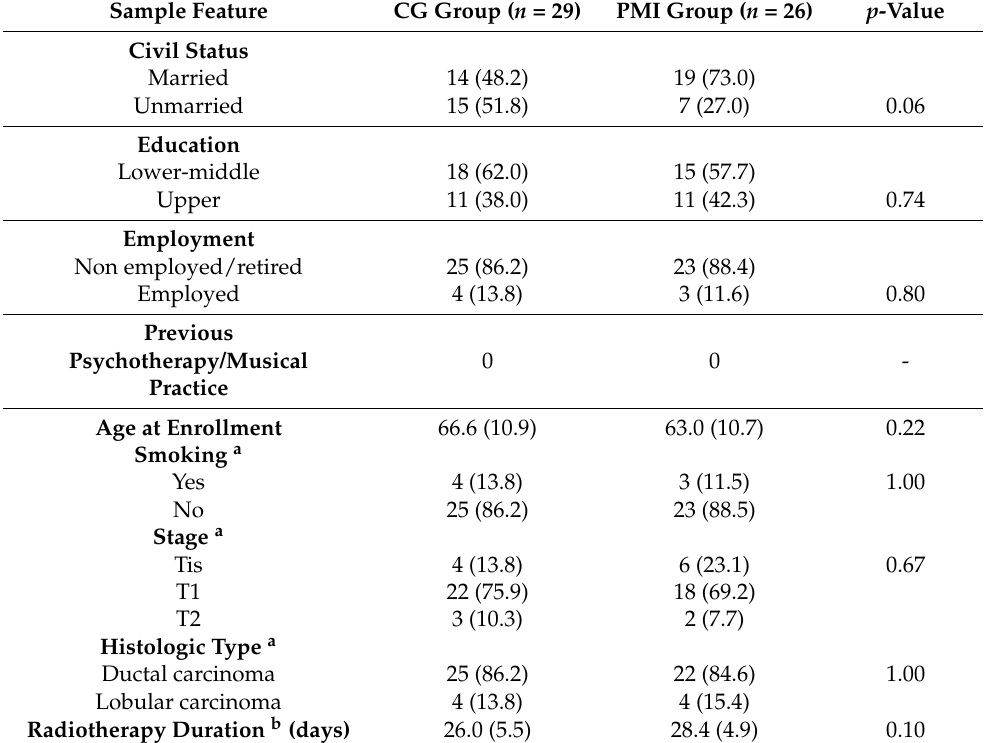
Table 1. Characteristics of the participants.